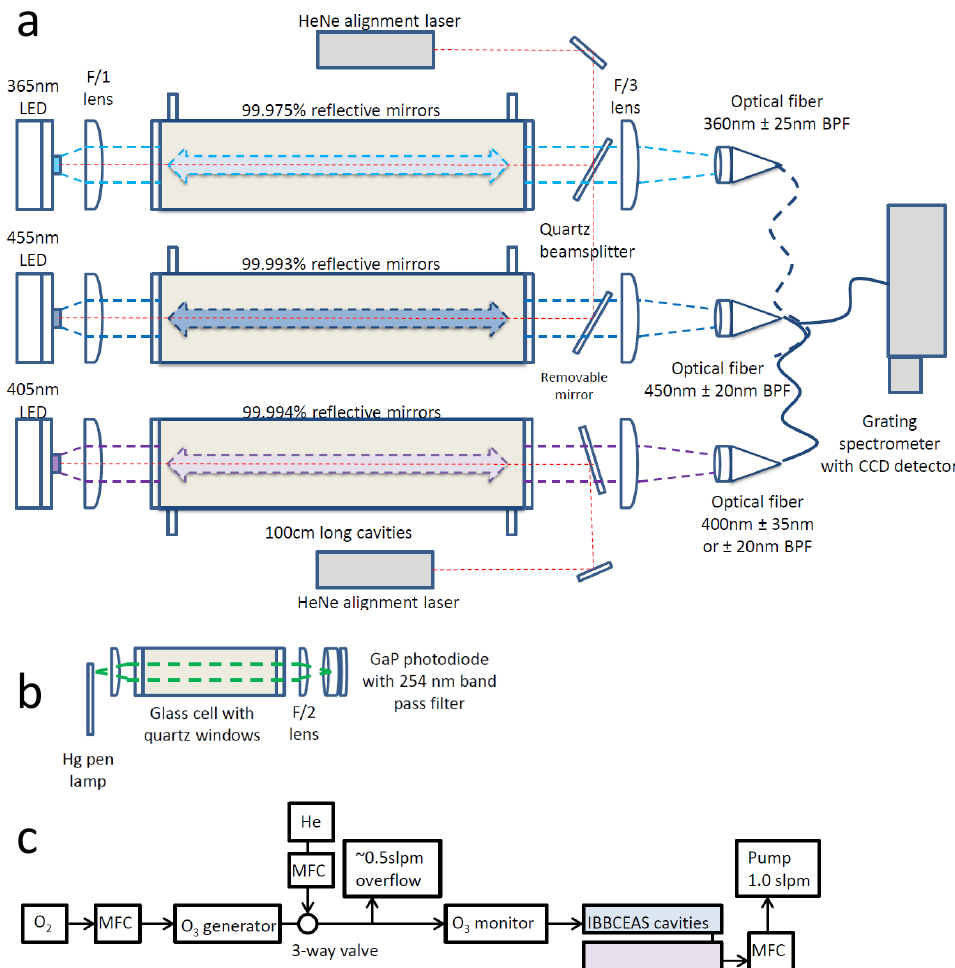
Fig. 1. (a) Schematic of the three channel IBBCEAS consisting of LED light sources, optical cavities, and a CCD detector. (b) Schematic of the ozone monitor, consisting of Hg light source and GaP photodiode. (c) Block diagram showing O 3 delivery system to the